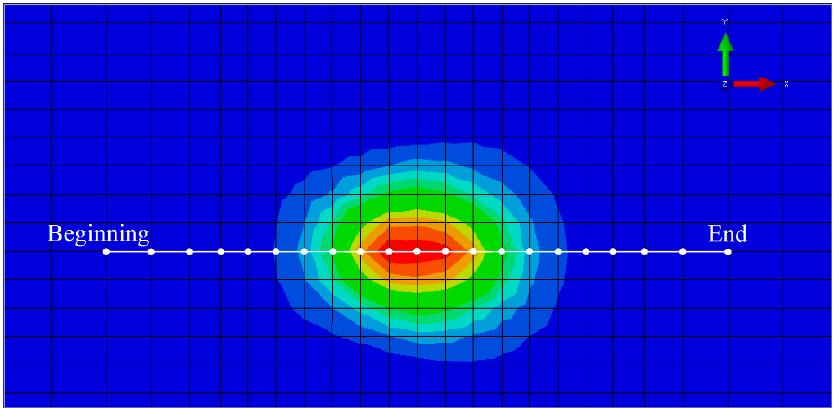
Figure 7. Vertical route of the tire movement.